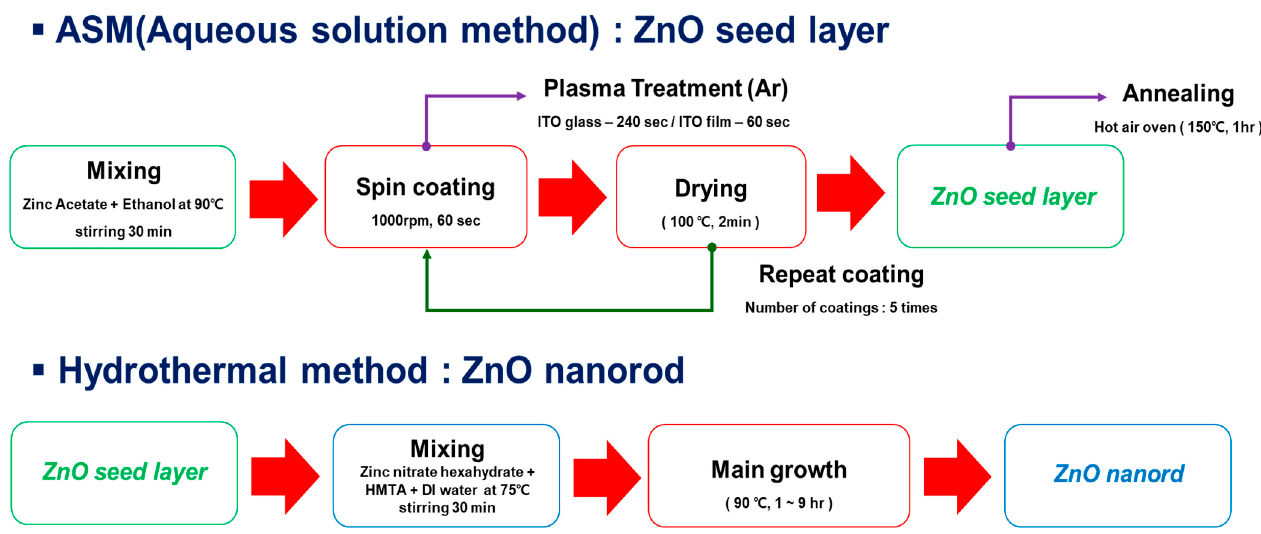
Figure 1. Procedures for ZnO seed layer formation by aqueous solution method and zinc oxide nanorod (ZNR) growth by hydrothermal method.